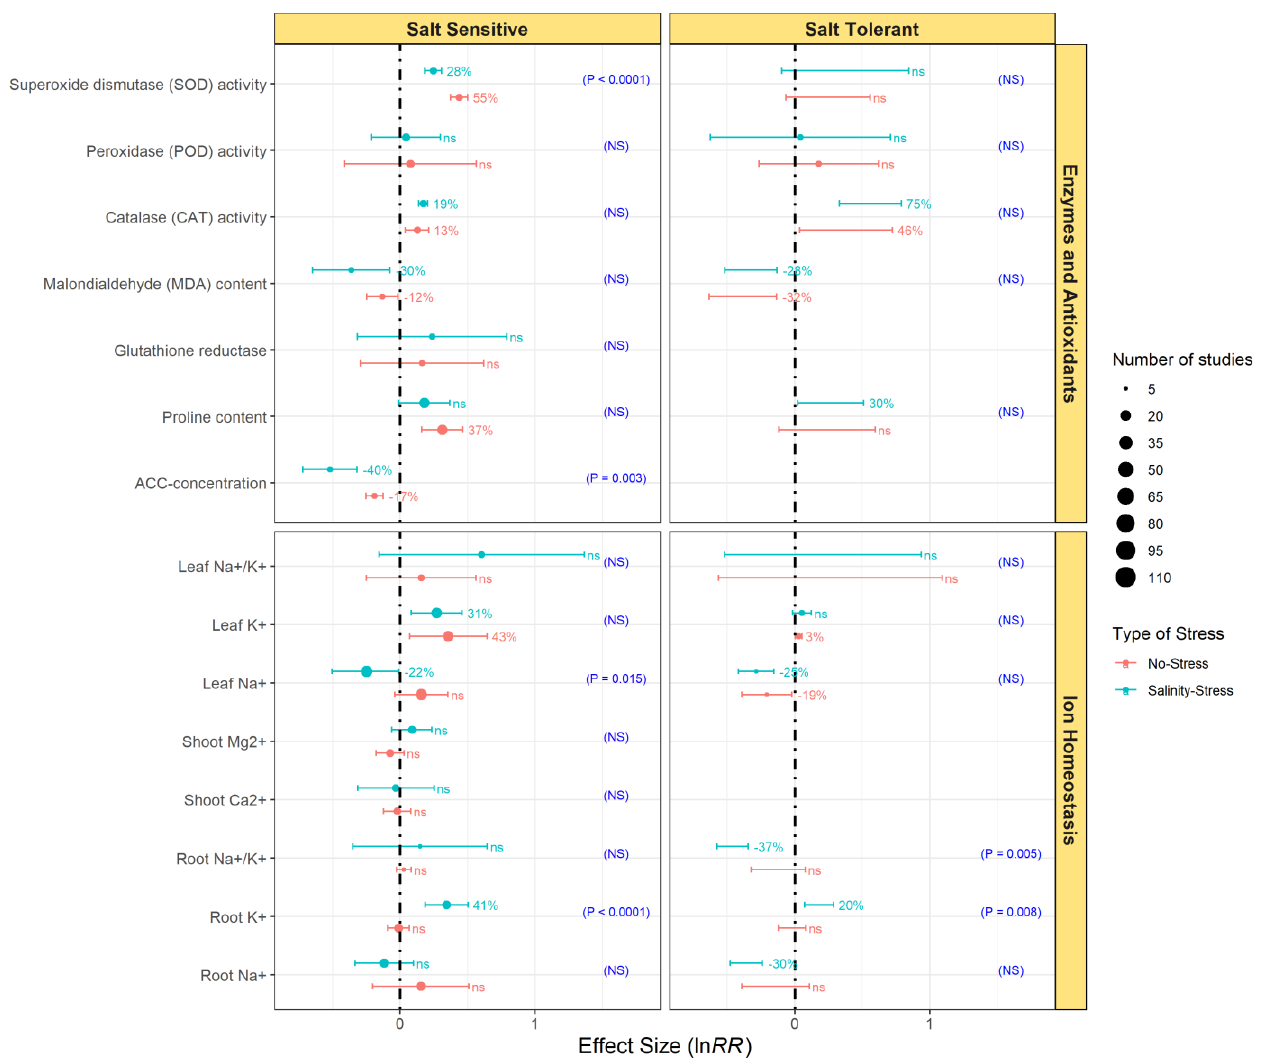
Figure 4. Effect of endophytic bacterial inoculation on enzymes and antioxidants, as well as on the ion homeostasis of salt-sensitive and salt-tolerant plants under no-stress and salinity-stress treatments. Error bars represent 95% confidence intervals (CIs). The inoculation effects were considered significant if the 95% CIs did not overlap with the zero line. The size of the scatter point shows the number of experimental observations. p -values and ‘NS’ in parenthesis show the significant and non-significant differences, respectively, between growth conditions.